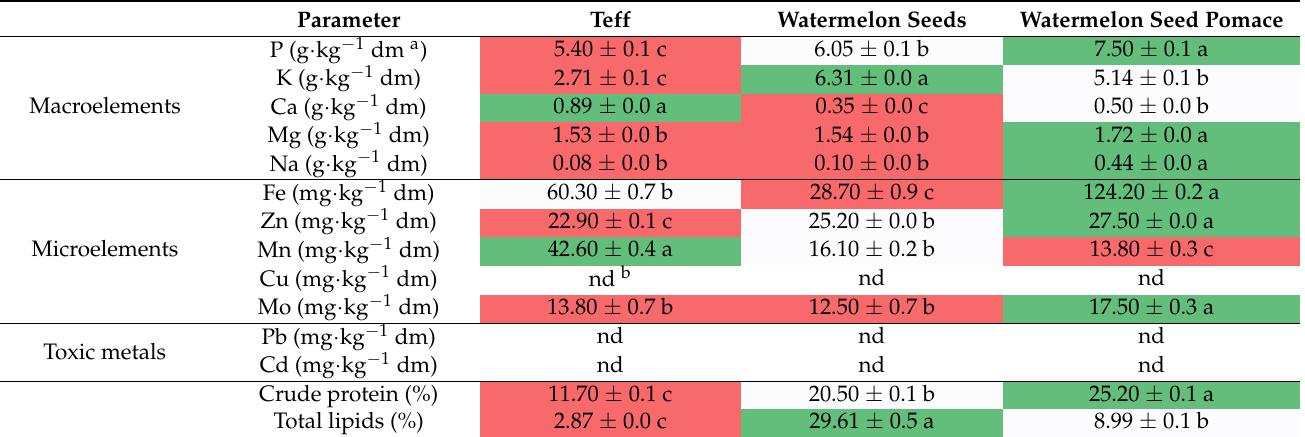
Table 1. Mineral, protein, and fat content in teff and watermelon seed flour samples (means ± SD). Parameter Teff Watermelon Seeds Watermelon Seed